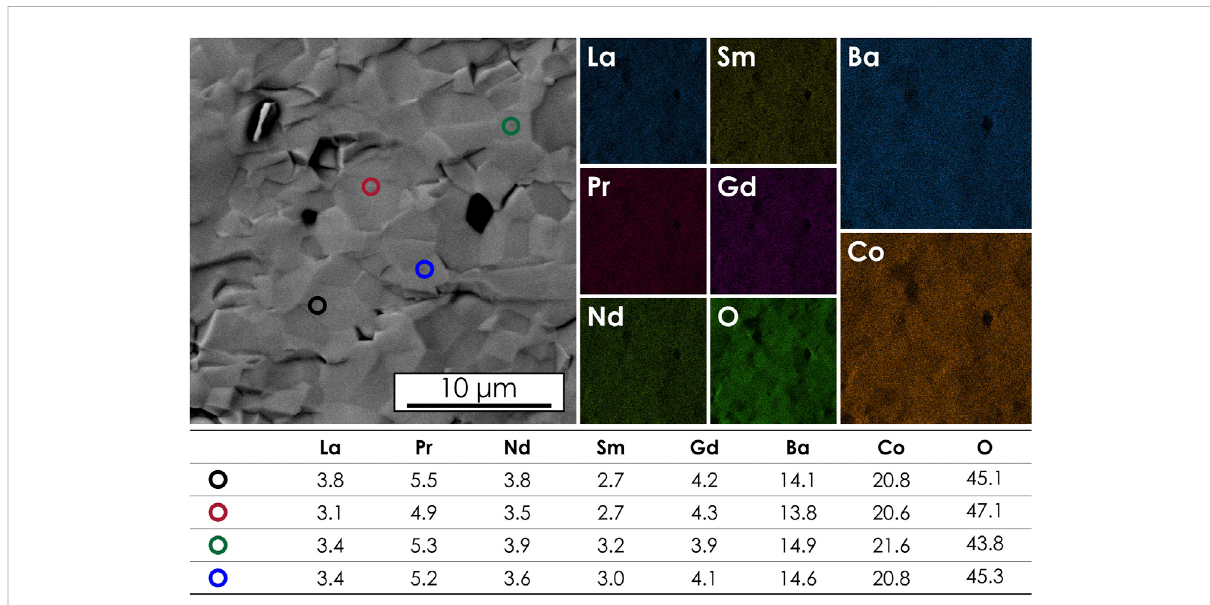
FIGURE 2 Micrograph taken from a fractured (La,Pr,Nd,Sm,Gd)BaCo 2 O 5+ δ pellet. Resultsof theEDS mappings and point analysisdata (at% values) are also